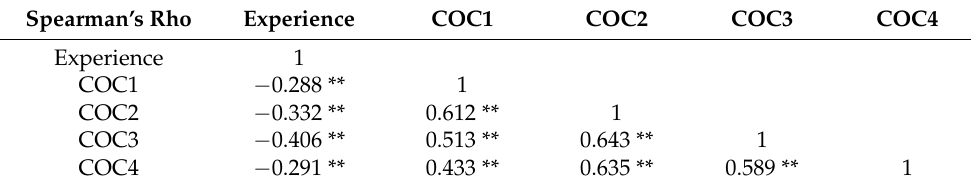
Table 13. Correlation coefficient between the H&S considerations in conditions of